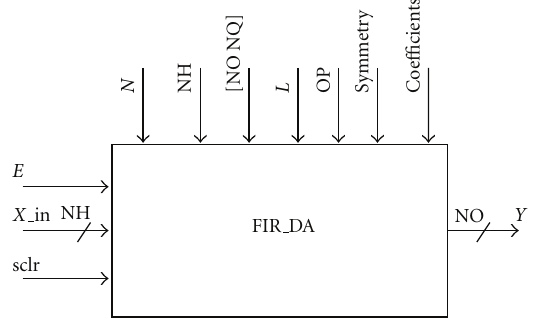
Figure 1: Generalized FIR DA module.